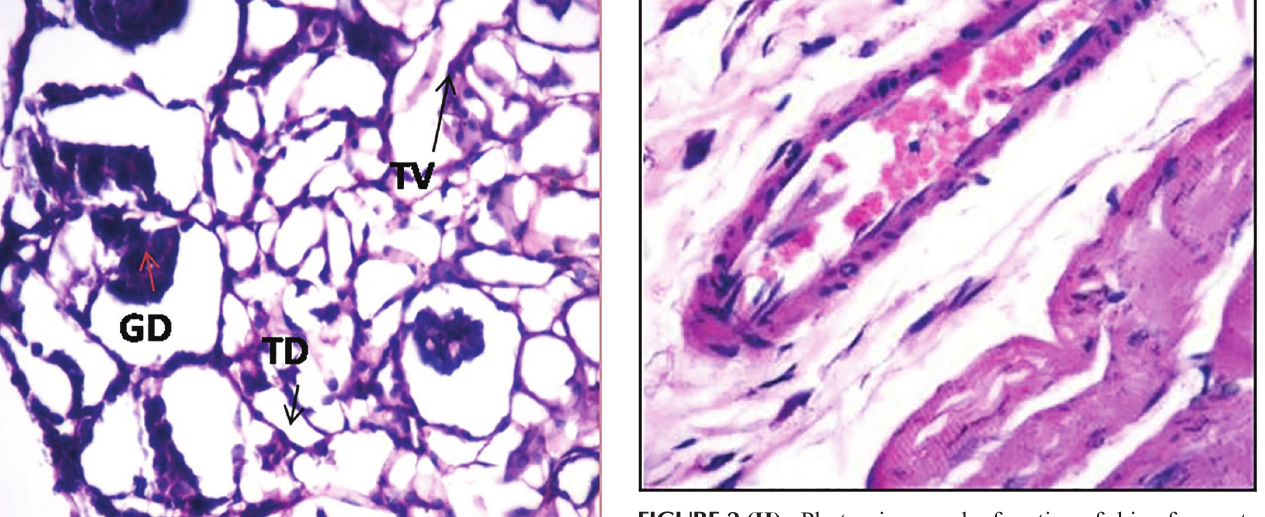
FIGURE 2 (H) - Photomicrograph of section of skin of neonate of pregnant rat exposed to pesticide glyphoshate shows dilated and congested blood vessels. (H & E